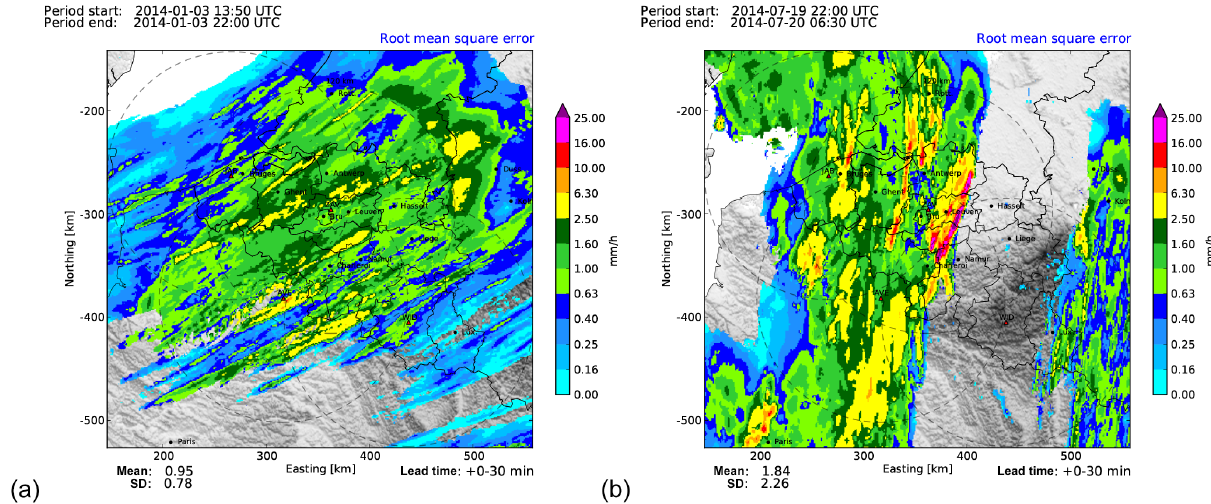
Figure 5. Average 0–30min forecast RMSE for (a) the Ghent winter case on 3 January 2014 and (b) the Leuven summer case on 19–20 July